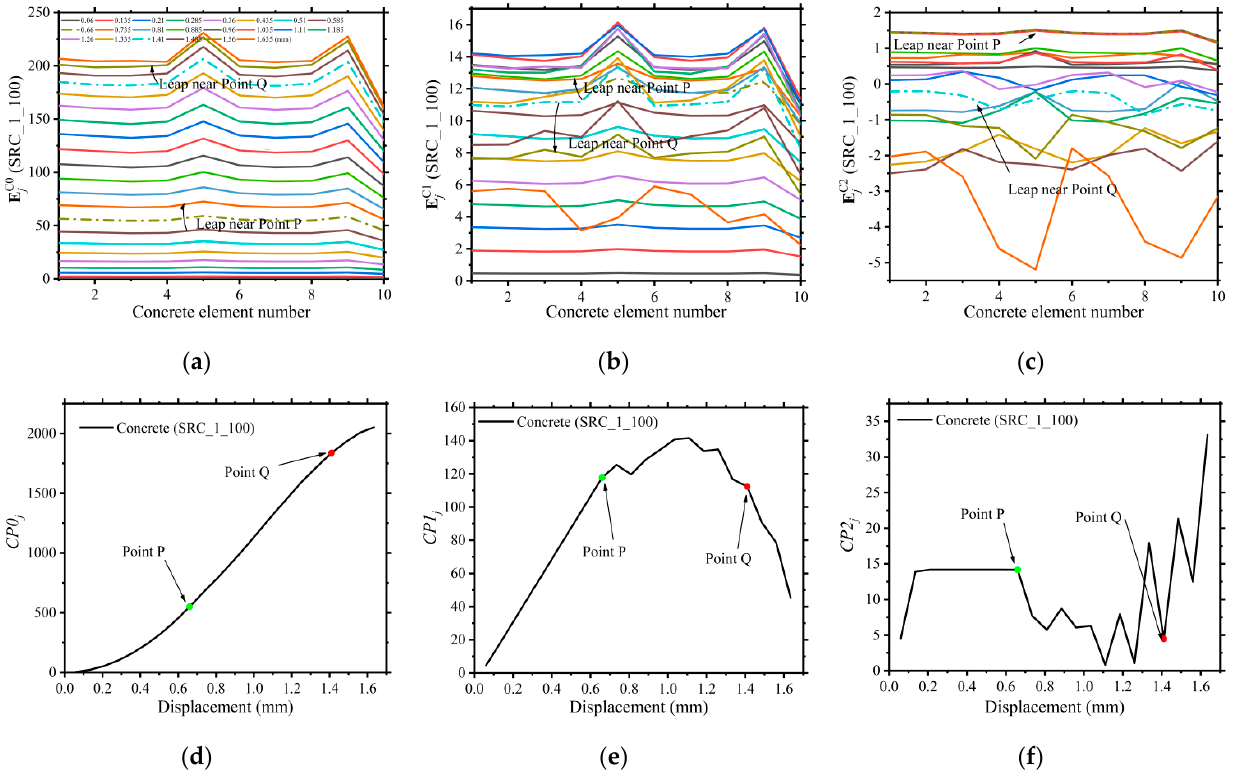
Figure 7. Concrete stressing state sub-mode revealed by ESE , ∆ ESE and ∆ 2 ESE : ( a ) Mode0 of concrete; ( b ) Mode 1 of concrete; ( c ) Mode 2 of concrete; ( d ) CP 0 of concrete; ( e ) CP 1 of concrete; ( f ) CP 2 of concrete.